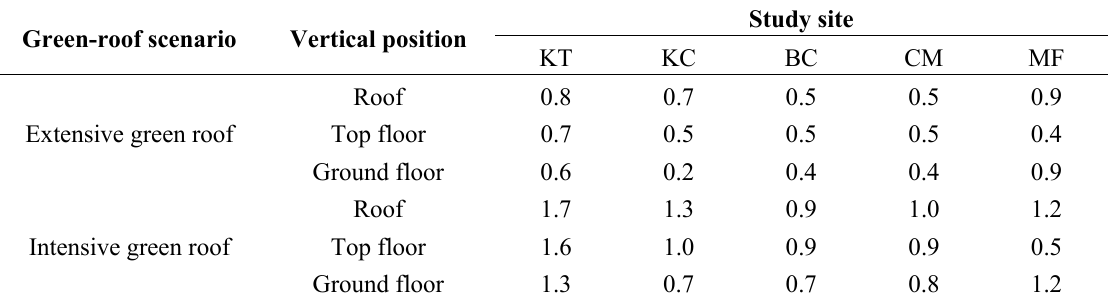
Intensive green